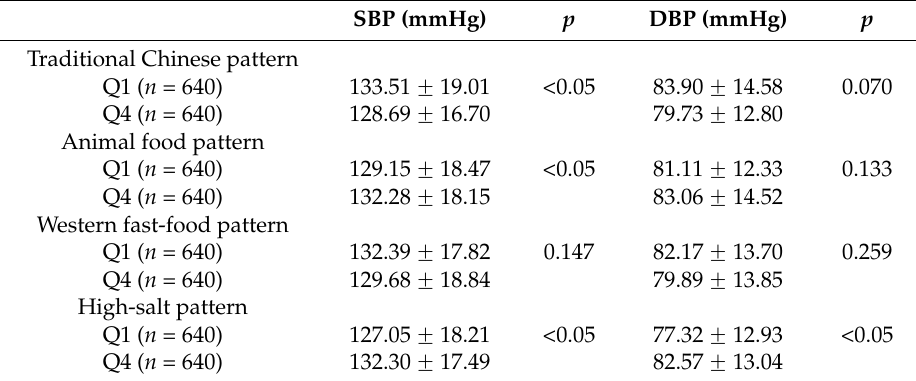
Table 3. Analysis of covariance model to evaluate the difference of SBP and DBP by quartile (Q) categories of dietary pattern scores.